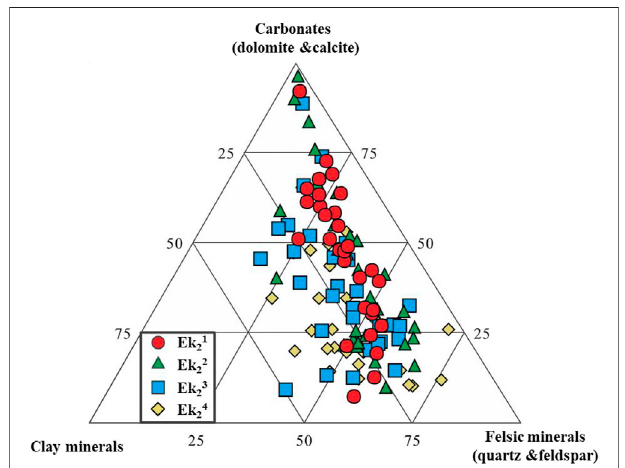
FIGURE 8 | Ternary diagrams of the whole-rock mineral component of the Ek 2